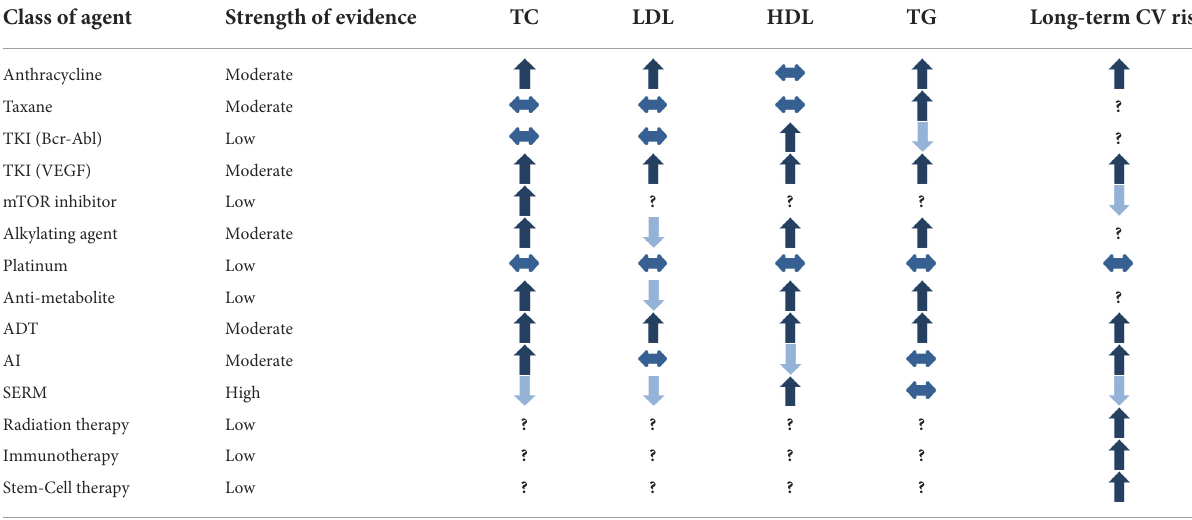
TABLE 1 Known effects of cancer therapies on lipid profile and CV risk a